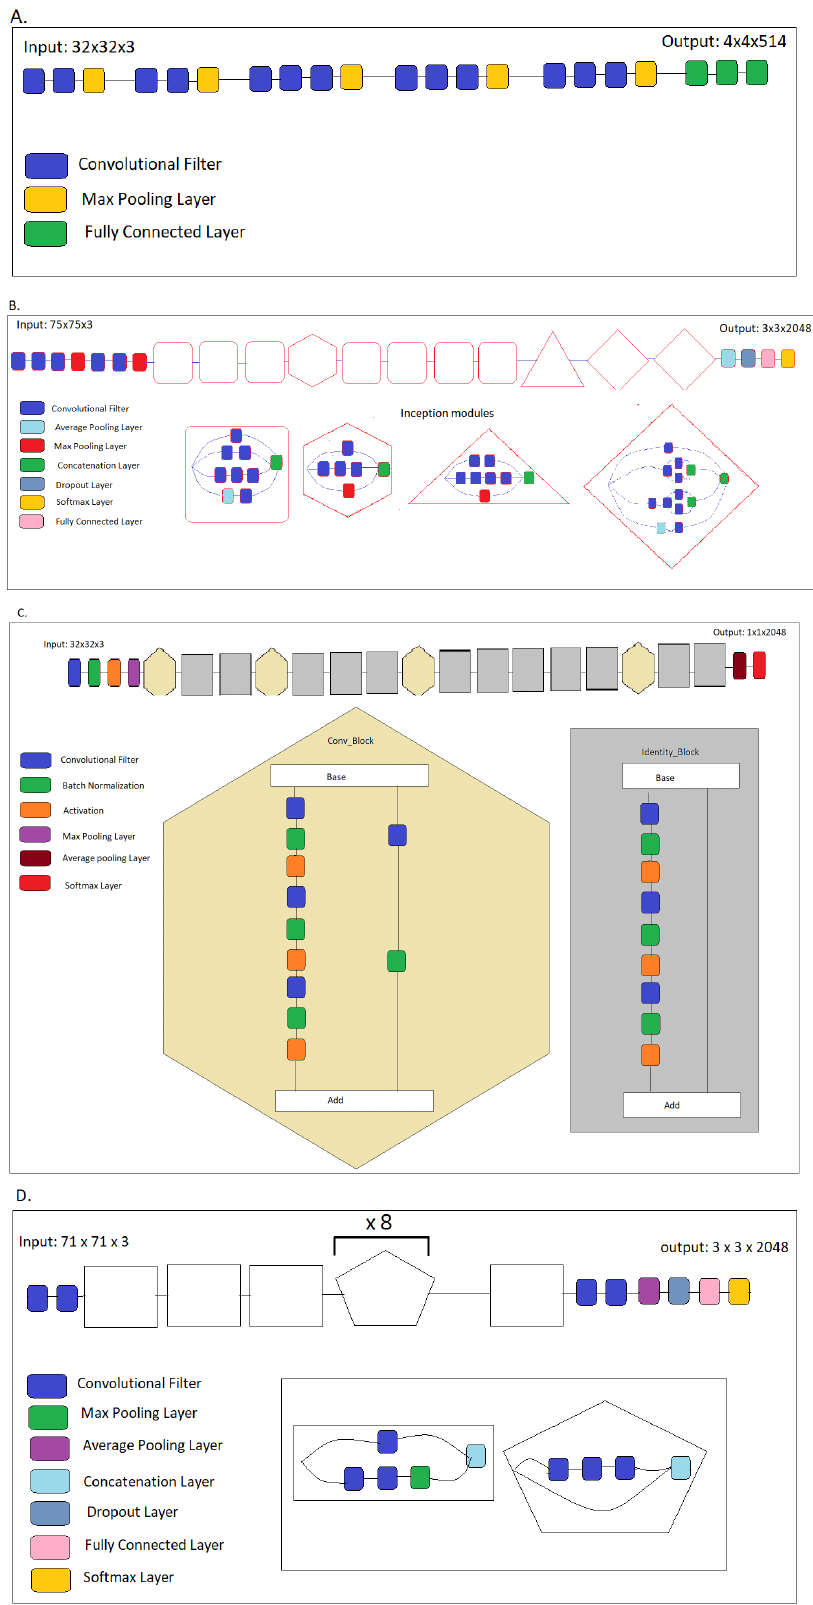
Figure 3. The graphical representation of the four network architectures investigated for extracting deep-learning features from images. ( A ) VGG16 architecture. ( B ) Inception V3 architecture. ( C ) ResNet50 architecture. ( D ) Xception